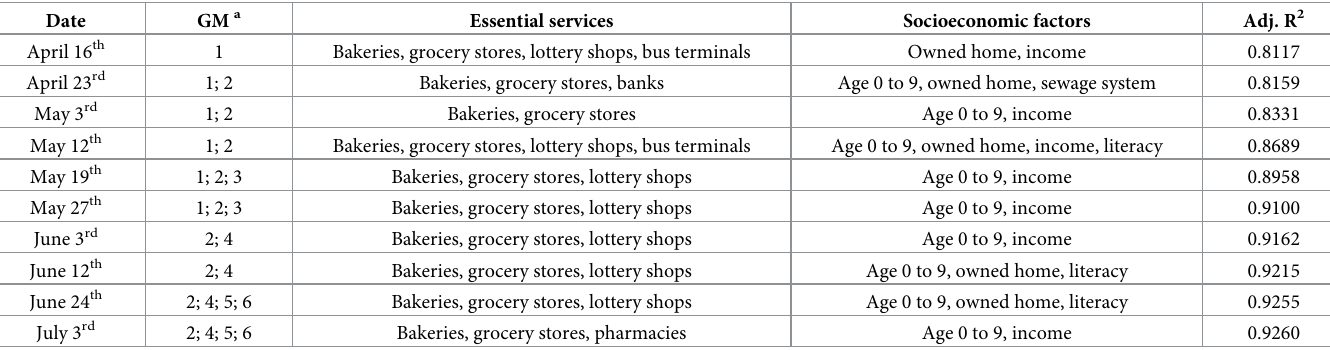
Table 3. The performance of OLS models over time using combined datasets of